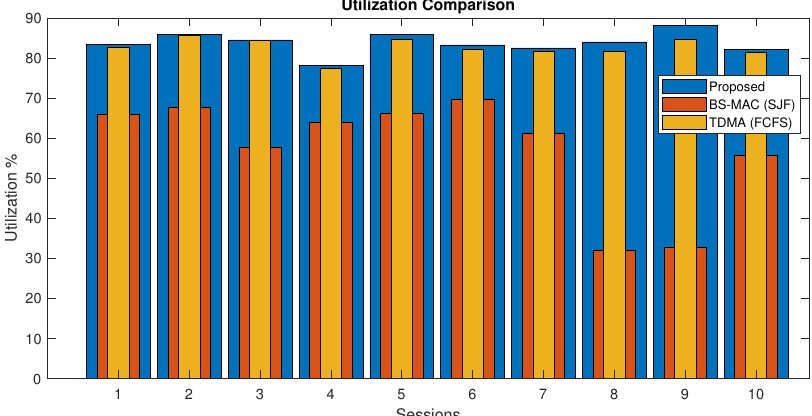
Figure 13. Channel utilization comparison of the proposed protocol (Case